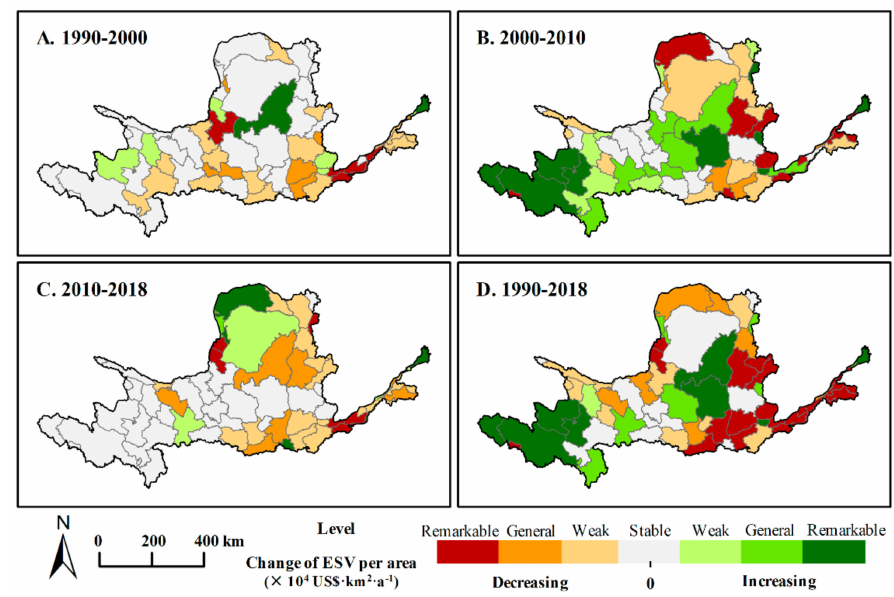
Figure 7. Change in spatial distribution of AESV in the YRB from 1990 to